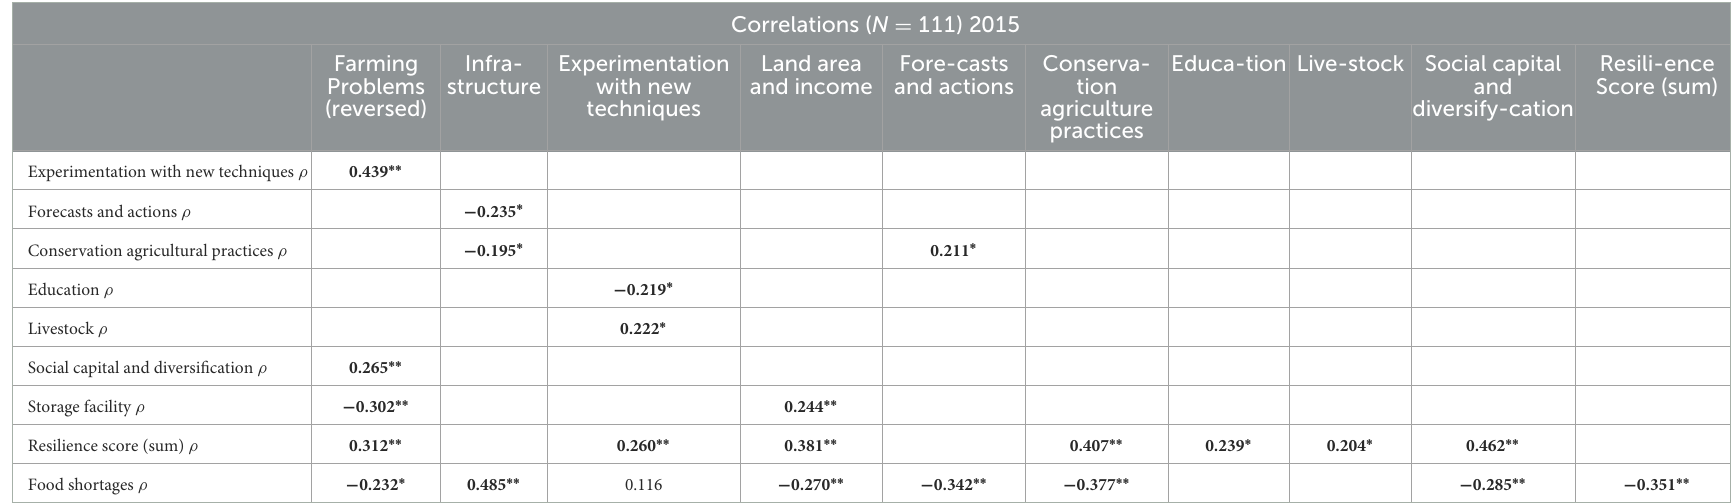
TABLE 6 Correlation matrix components of resilience 2015 (significant